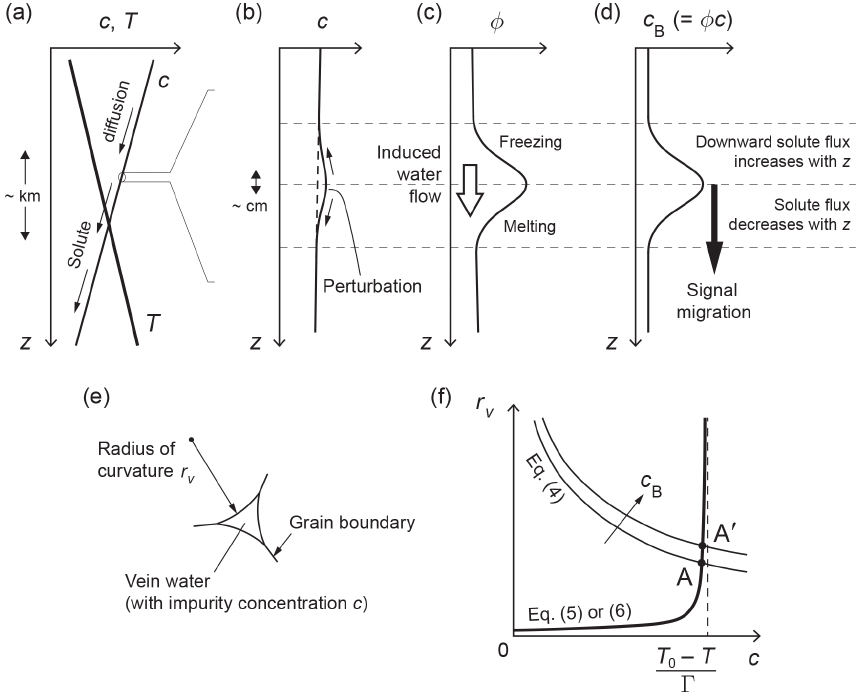
Figure 2. Interactions that cause the signal migration mechanism of Rempel et al. (2001) and our signal diffusion mechanism, and variables studied in this paper. (a) Conceptualisation of the vertical profiles of vein impurity concentration c and ice temperature T in an ice core; z is depth below the surface. The gradients shown here typically occur over the kilometre length scale and are most pronounced towards the base of an ice sheet; see Fig. 4 for real examples of T (z) . Panels (b) , (c) , and (d) expand on the variations around a c B signal, which occur at a much shorter scale of decimetres or centimetres. (b) Vein impurity concentration c . (c) Porosity φ . (d) Bulk impurity concentration c B . (e) Vein cross-sectional geometry, showing the definition of the radius of curvature r v . (f) Equilibrium vein conditions as the solution of model equations. An increase in c B lifts the solution A to A’, causing a perturbation on c (see panel b ) that drives c B diffusion. Neglect of the Gibbs–Thomson effect in the theory of Rempel et al. (2001) causes the bold curve in (f) to collapse onto the vertical dashed line; then no perturbation arises to diffuse the